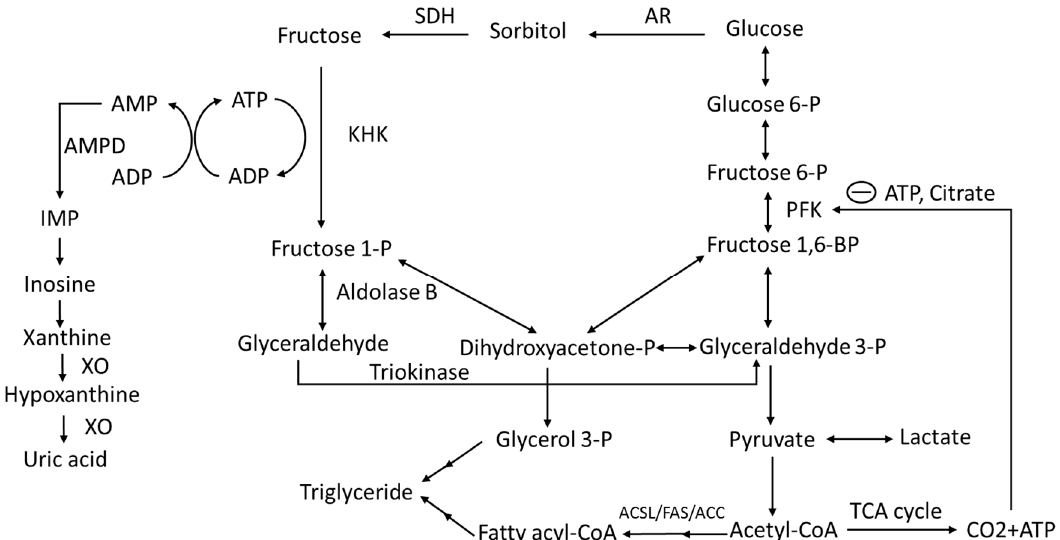
Figure 1. Fructose and Glucose metabolism. AR, aldose reductase; SDH, sorbitol dehydrogenase; KHK, ketohexokinase; PFK, phosphofructokinase; AMPD, adenosine monophosphate deaminase; IMP, inosine monophosphate; XO, xanthine oxidase; ACC, acetyl-CoA carboxylase; FAS, fatty acid synthase; ACSL, long chain acyl-CoA synthetase.